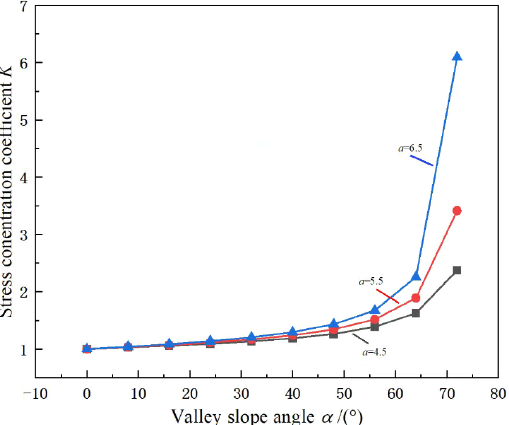
Figure 8. Variation curve of stress concentration coefficient K with valley slope angle α .